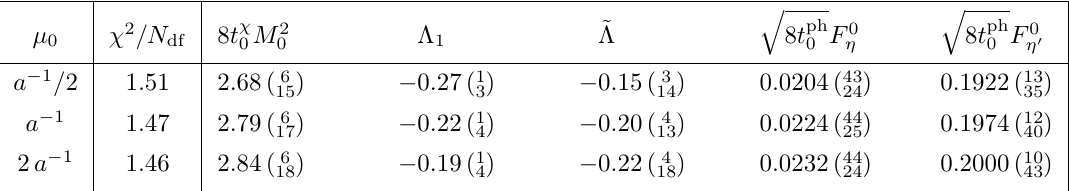
, varying the scale at which we match to perturbation theory. A